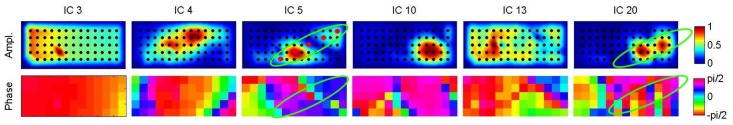
Magnitude and phase patterns of all discriminative ICs found with the sparse bilinear classifier in finger movement data, task “lift ring finger” versus “lift little finger”.The upper row shows the normalized amplitude pattern. Black dots mark the position of the sensors and values in between are obtained by bi-cubic interpolation. The lower row shows the corresponding phase information. Here no interpolation was done because of the periodicity of the phase. Note that phase information is only meaningful in locations where amplitude is non-zero. The sensors showing interesting phase distribution are denoted by the ellipses. The left side of the array is pointing towards the wrist, right side towards the elbow (see Fig 1).